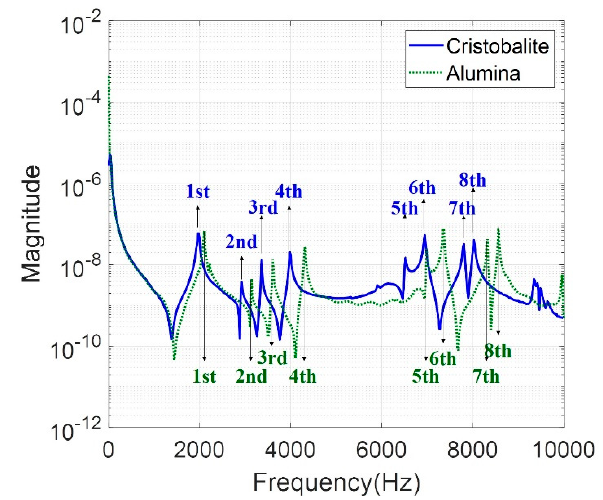
Figure 5. Natural frequency of FRF results according to material.